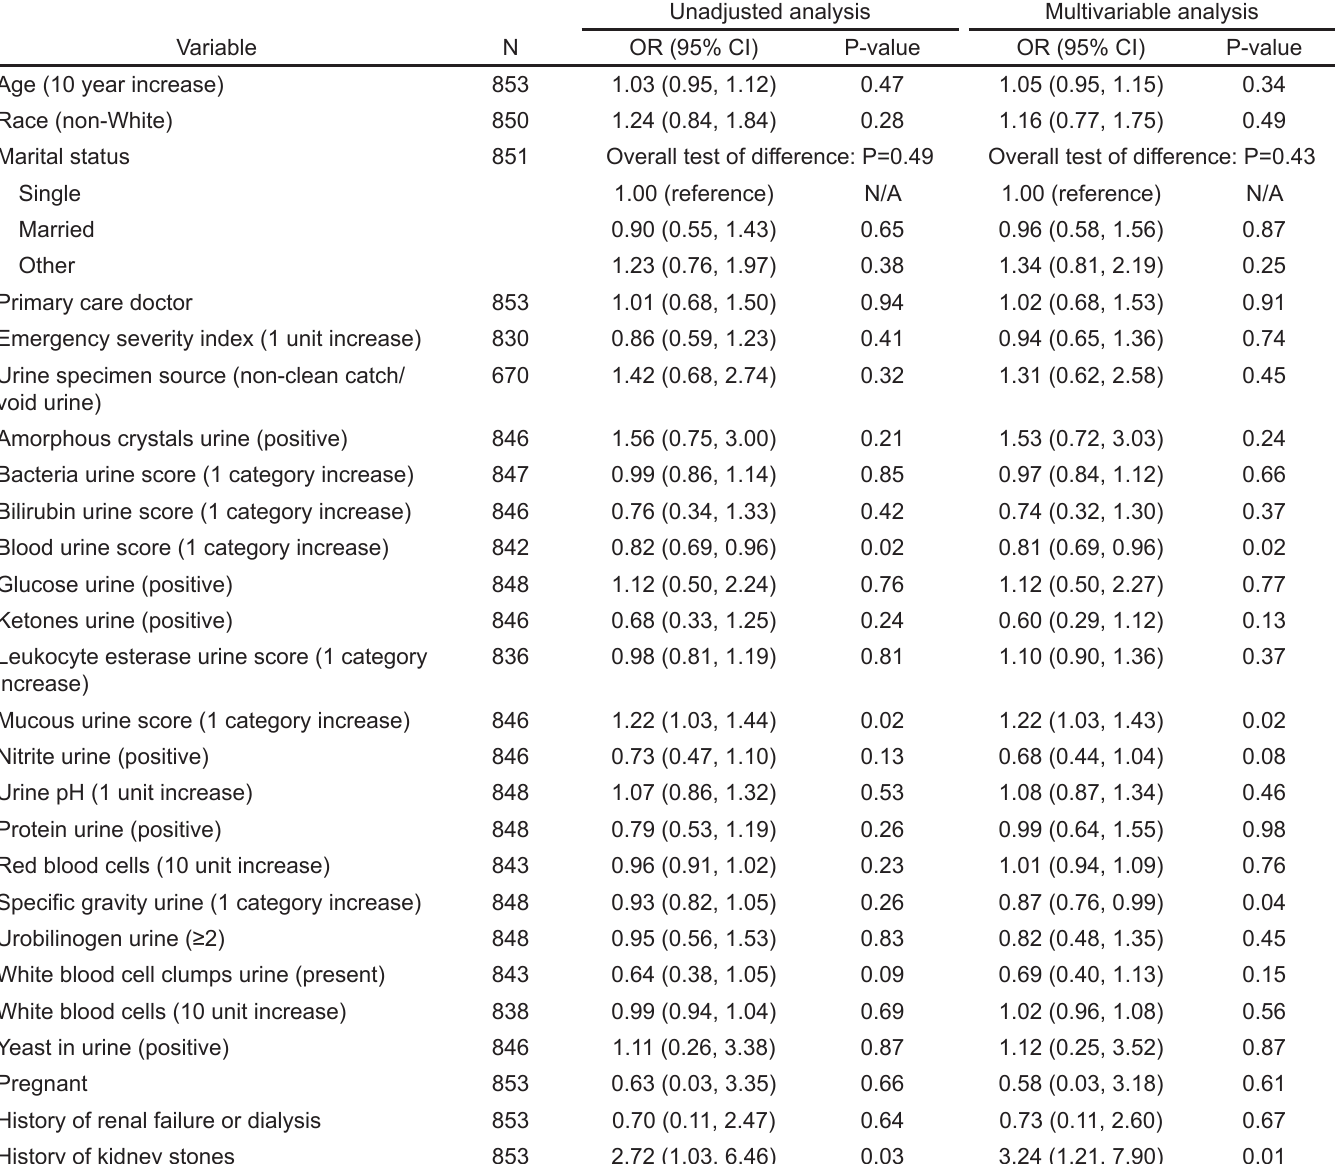
Table 2. Evaluation of predictors of resistance to